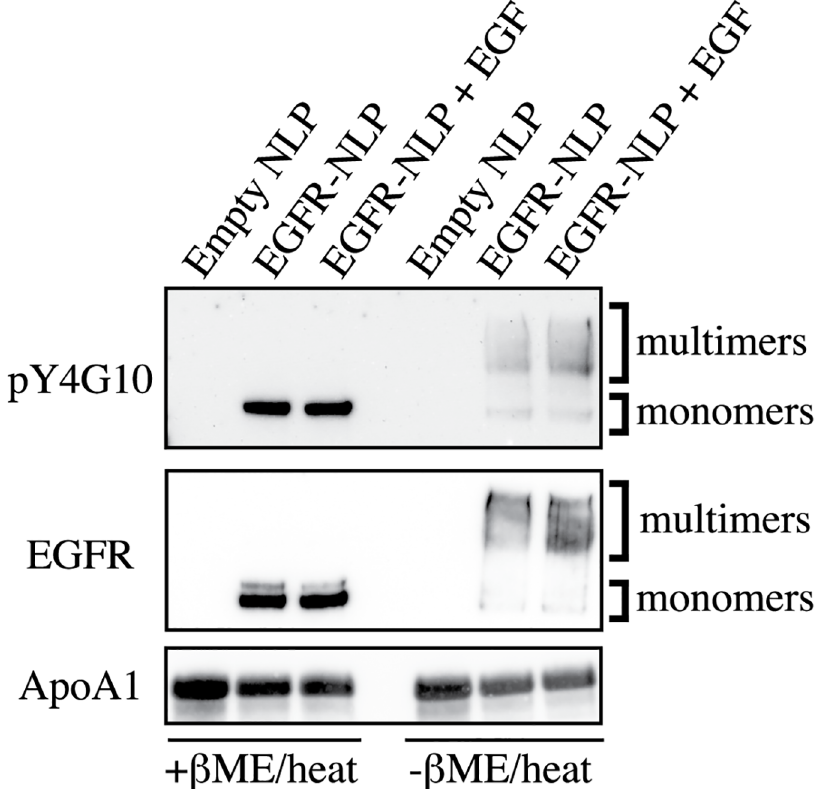
Fig 5. NLP assemblies contain EGFR monomers, dimers, and multimers. Empty and EGFR-NLPs were separated by SDS-PAGE with (+ β -ME/heat) and without denaturingconditions(- β -ME/heat)to observe EGFR multimers and analyzedby immunoblotting with anti-pY4G10, anti-EGFR, and anti-ApoA1 antibodies. Similar results were observedin each of three biologicalreplicates. Numbers indicateband intensity relative to EGFR-NLPs normalizedto ApoA1